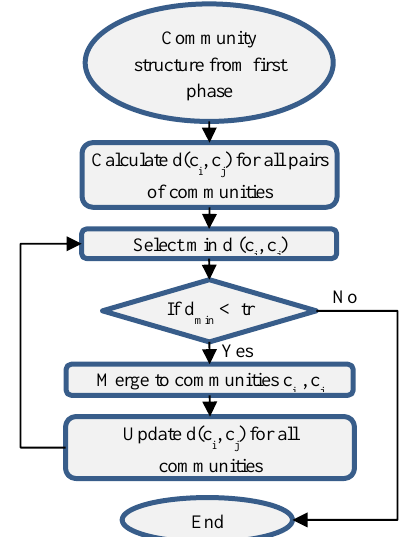
Community structure from